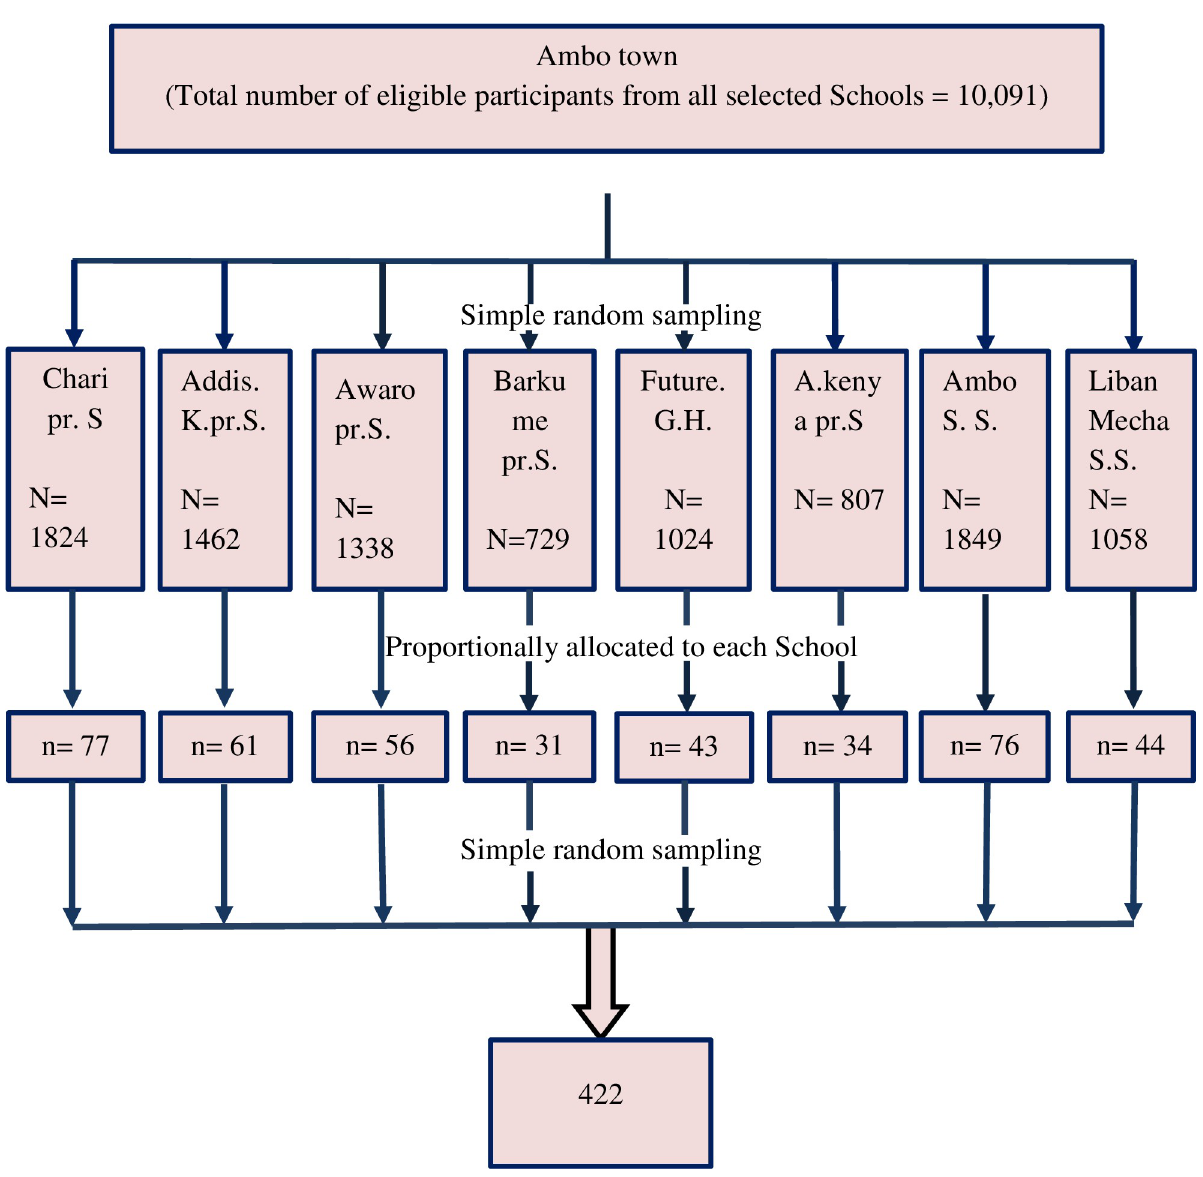
Fig 1. Schematic presentation of the sampling procedure on uptake of human papillomavirus vaccination and its associated factors among adolescent school girls in Ambo town, central Ethiopia, 2020. Gr-Grade, Pr- primary school, S.S–Secondary